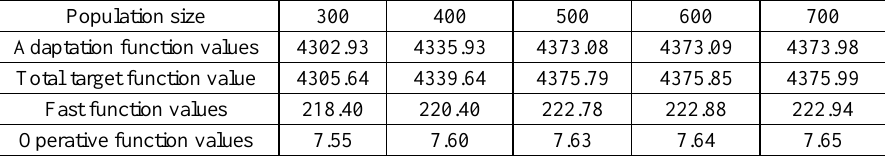
Table 5 . M 08 Calculation results of different population sizes.